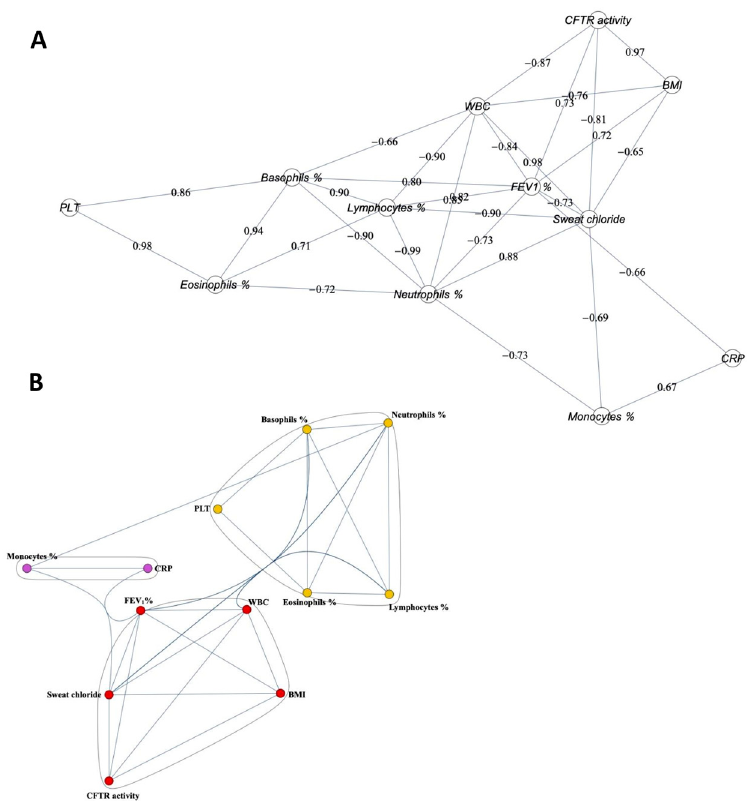
Figure 4. Correlations and cluster analysis over all time points during Orkambi treatment: ( A ) correlation graph; and ( B ) cluster analysis.